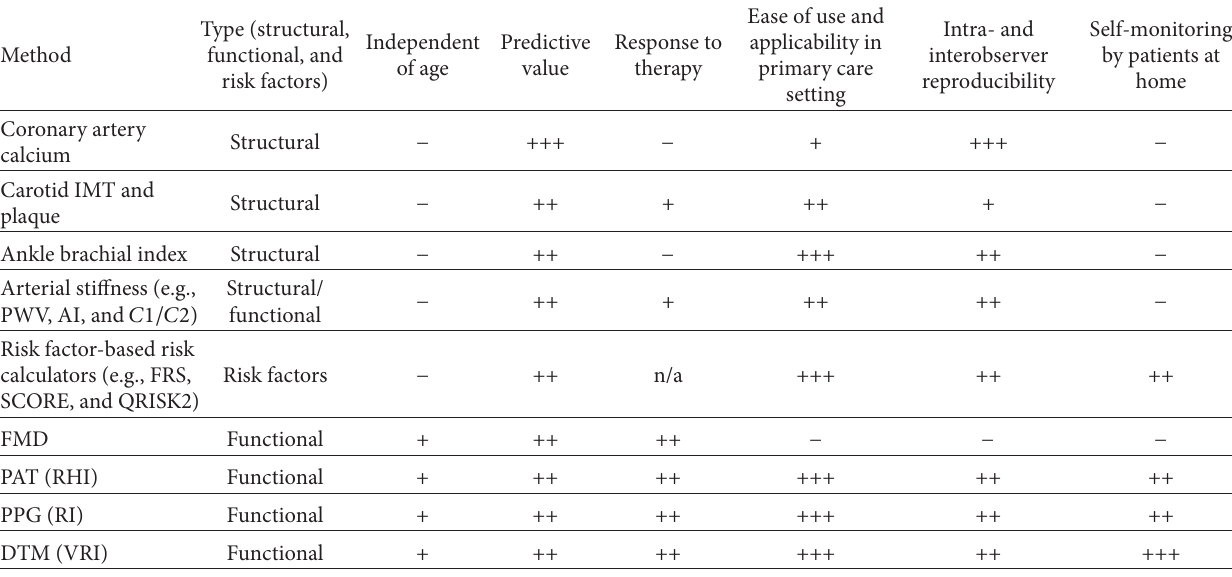
Table 3: Comparison between CVD risk assessment